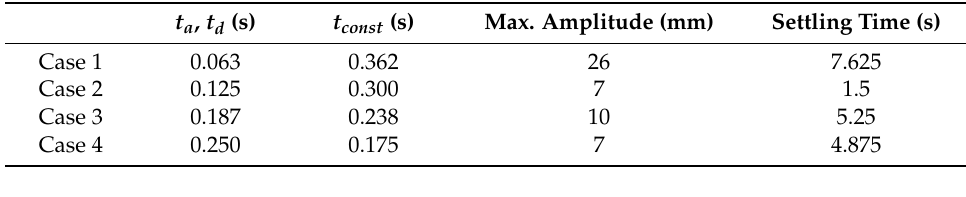
Figure 17. The velocity profiles when moving 425 mm with a maximum velocity of 1000 mm/s. Table 4. Experimental results of maximum amplitude and settling time when moving 425 mm with